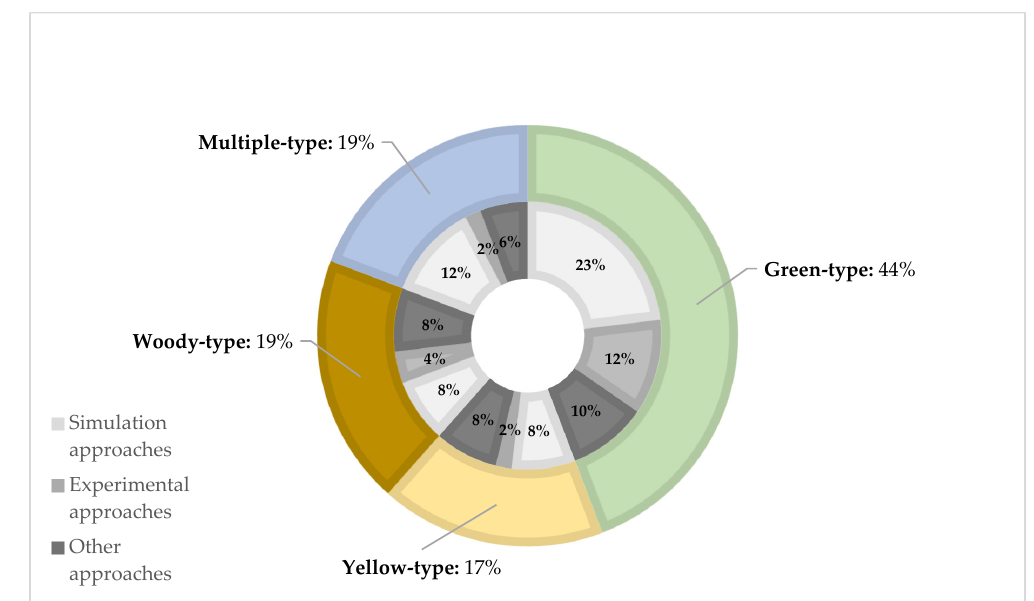
Figure 5. Biomass type and methodological approaches correlation.